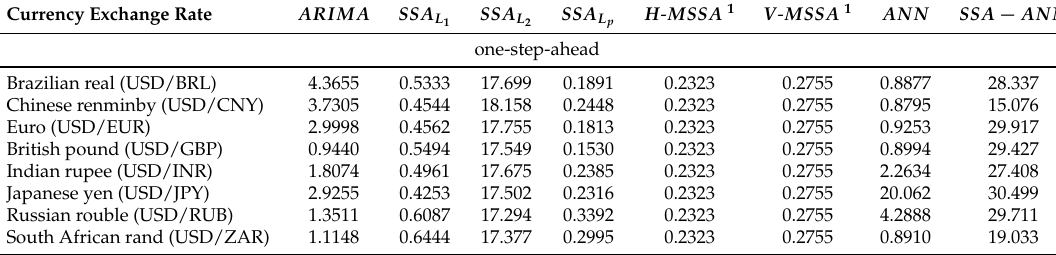
Table 9. Computational time, in minutes, for model fit, for each of the eight currency exchange rates, considering each of the eight models/algorithms, ARIMA, SSA for the window length and number of eigentriples for reconstruction as defined in Table 3, multivariate SSA for the window length and number of eigentriples for reconstruction as defined in Table 3, ANN, and the hybrid method that combines SSA and